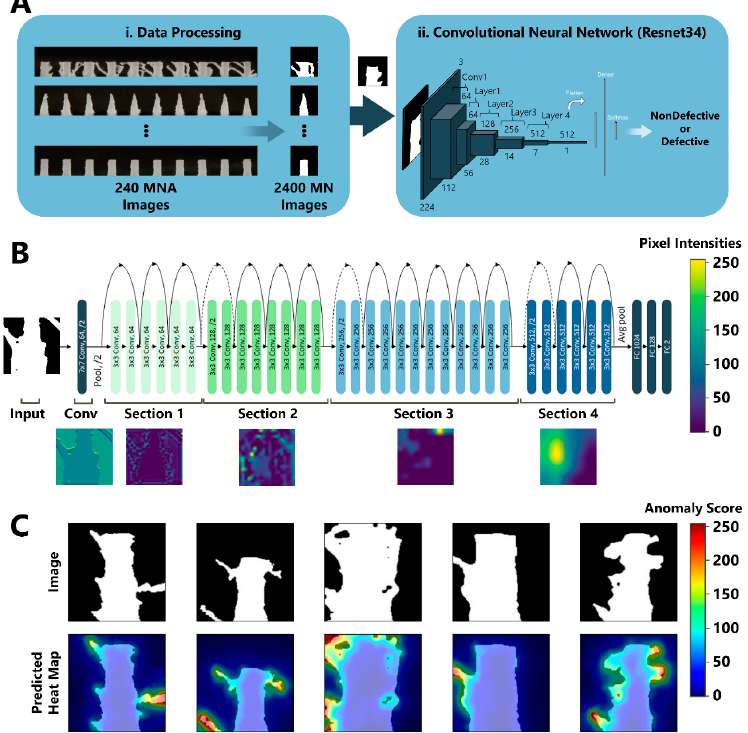
Figure 3. Image-based classification and anomaly detection using DL. ( A ) To use the MNA image dataset for the defect detection task, a data processing pipeline was implemented in which ( i ) each MNA image was automatically cut and binarized to separate individual MN images. Upon labeling all MNs as “Non-Defective” or “Defective” by expert review, the dataset was used for training CNN models. ( ii ) The resulting individual MN images were fed into Resnet34 CNN to be classified as “Non-Defective” or “Defective”. ( B ) Visualization of Resnet34 layer activation, where four ResNet sections are utilized in the CNN. The defective areas get higher pixel intensities throughout the network. ( C ) DL-based anomaly detection using PaDiM. Individual MNs were first binarized (top row) and then were used as an input for the PaDiM algorithm to generate heat maps of the anomaly scores of the MNs (bottom row). Anomaly scores are represented by pixel intensities between 0 (e.g., no anomaly) and 255 (e.g., extreme anomaly).